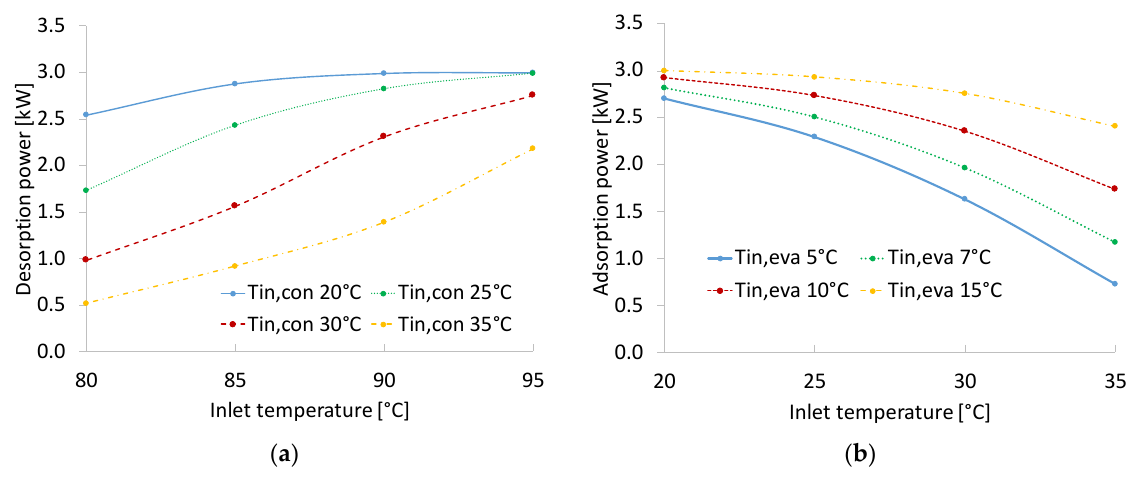
Figure 6. Charging ( a ) and discharging ( b ) performance map of a 100 kg sorption module.